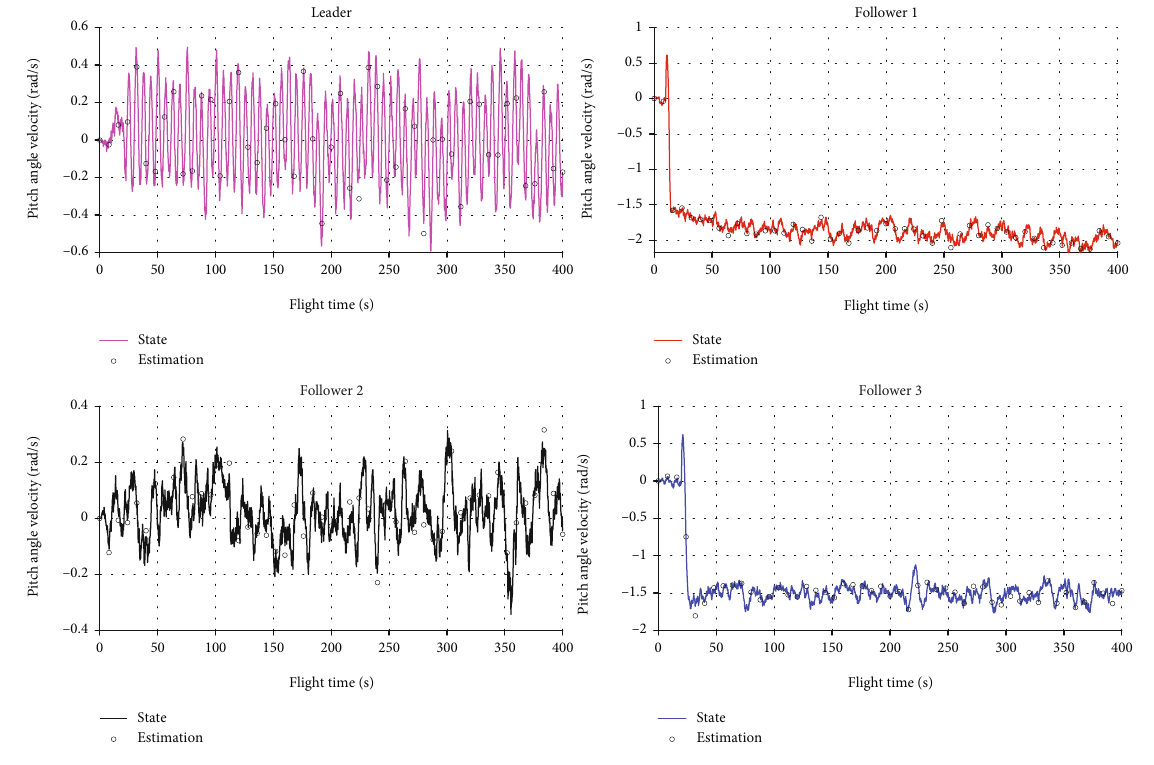
Figure 11: The system pitch angle velocity and estimation.